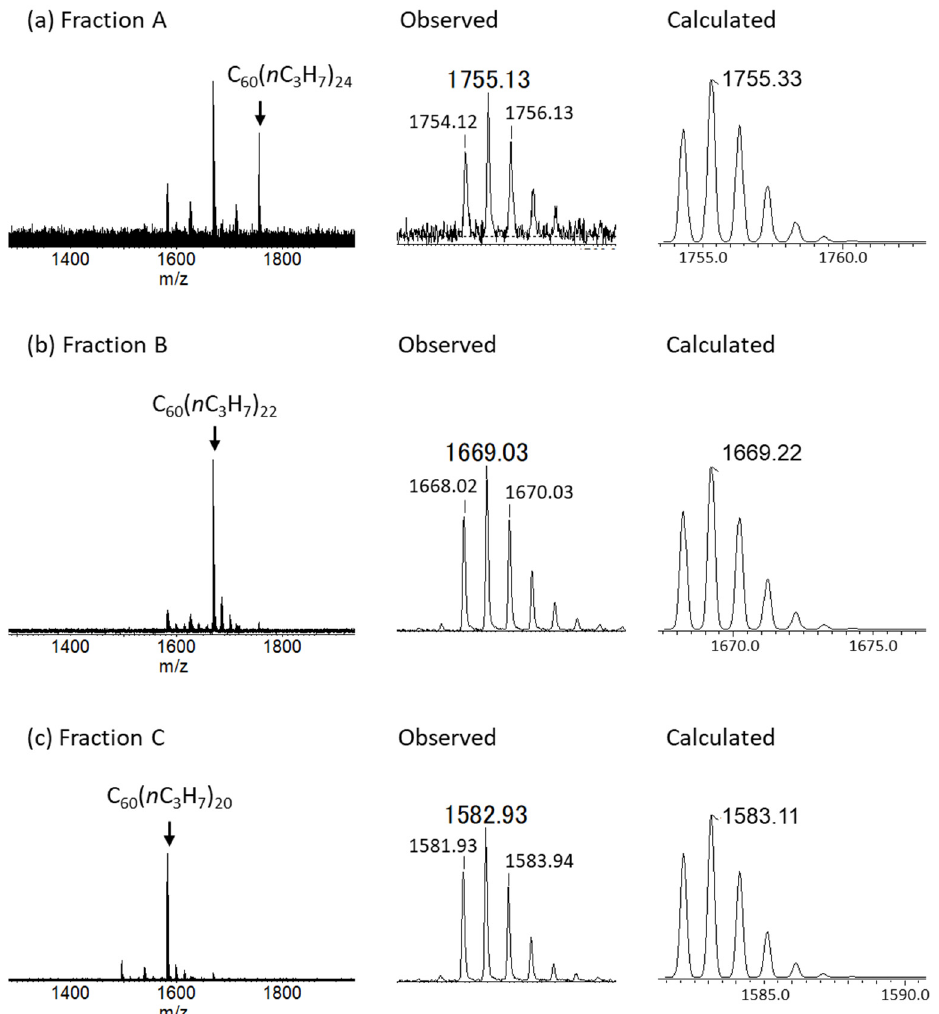
Figure 4. DART-MS (positive) of Fractions A , B , and C obtained through column chromatography (SiO 2 , eluent: n -hexane), the predominant components of which are ( a ) C 60 ( n C 3 H 7 ) 24 , ( b ) C 60 ( n C 3 H 7 ) 22 , and ( c ) C 60 ( n C 3 H 7 ) 20 , respectively. Left : observed whole spectra of each C 60 ( n C 3 H 7 ) n fraction. Middle: enlarged isotopic patterns of the corresponding C 60 ( n C 3 H 7 ) n (n = 24, 22, 20). Right : simulated isotopic patterns of C 60 ( n C 3 H 7 ) n (n = 24, 22, 20) as [M + H] + .